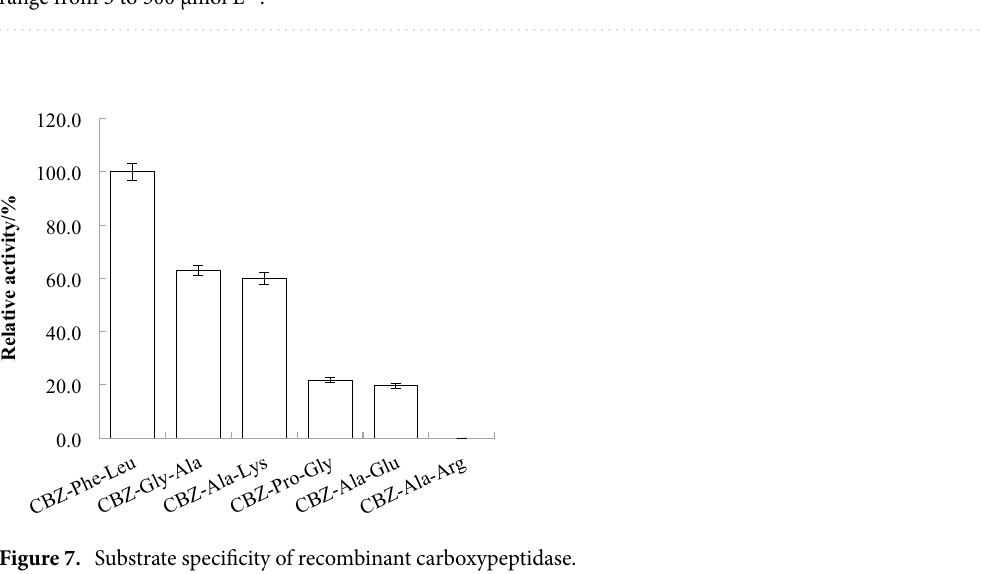
Table 3. Kinetic parameters for 5 CBZ-aa-aa substrates by carboxypeptidase CapA. Assays were carried out in 0.1 mol L −1 disodium hydrogen phosphate-citric acid buffer, at pH 6.0, 45 °C. The concentrations of CapA range from 5 to 500 μmol L −1 .